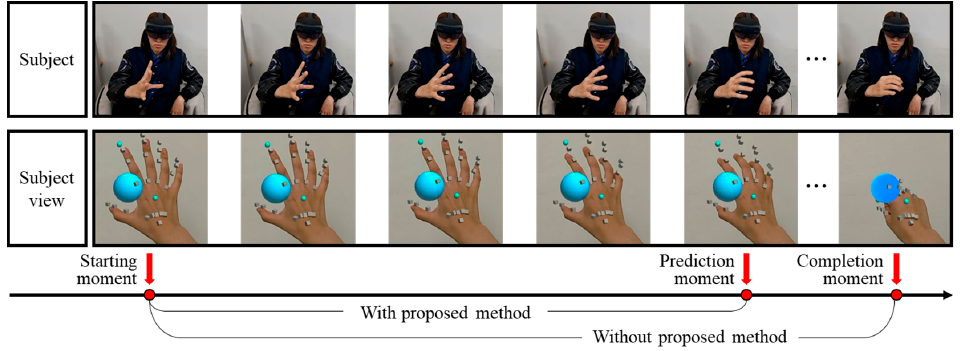
Figure 9. Task time of each subject measured during the experiment.